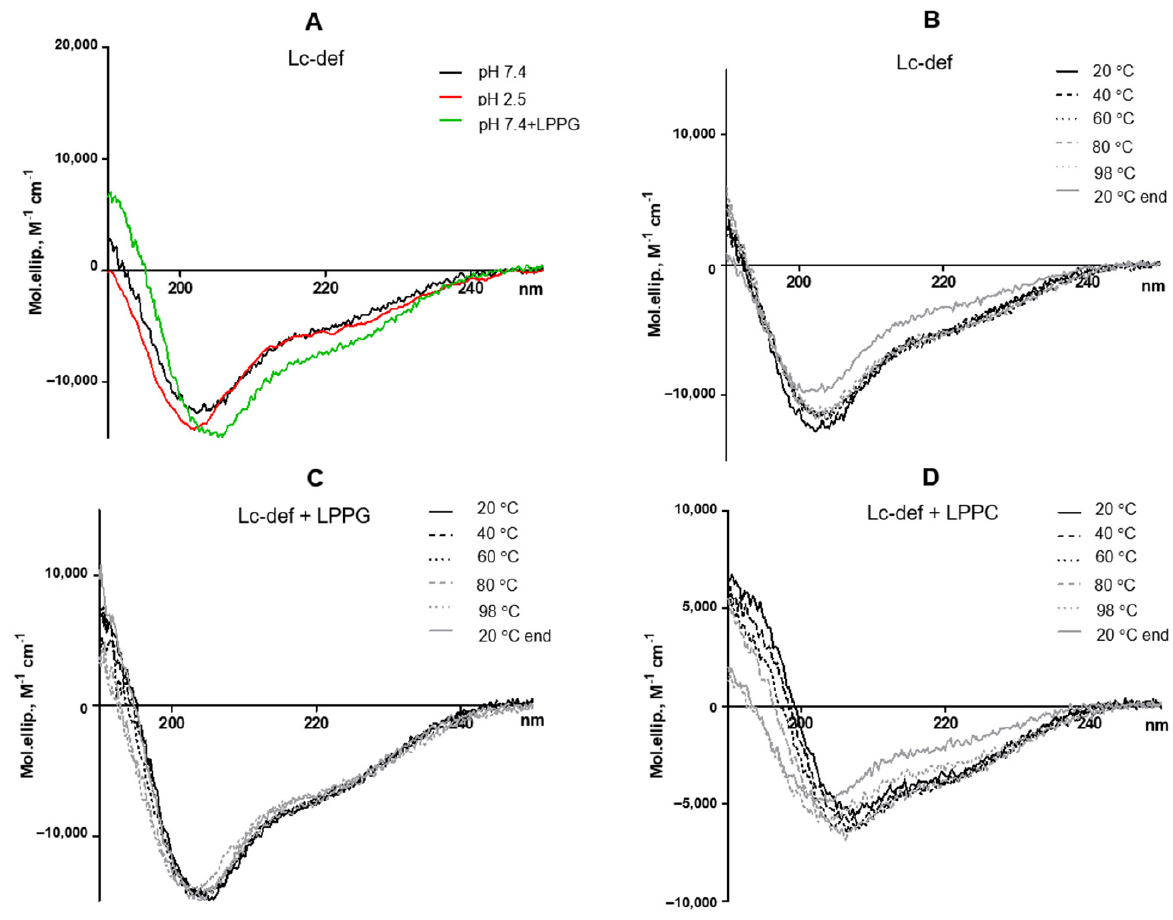
Figure 1. CD spectra of lentil Lens culinaris defensin at 20 °C at different pH without or in the presence of LPPG ( A ). Effects of heating up to 98.5 ° С and subsequent cooling down to 20 °C on the secondary structure of Lc-def without ( B ) or in the presence of lysolipids LPPG ( C ) and LPPC ( D ) at final concentrations of 1 mM.